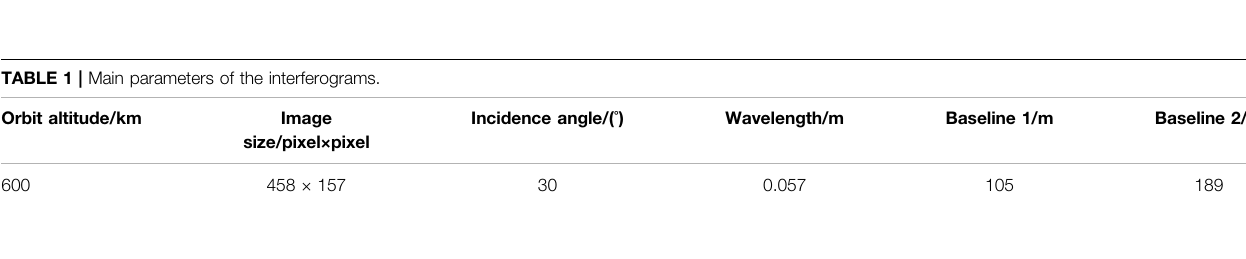
TABLE 1 | Main parameters of the